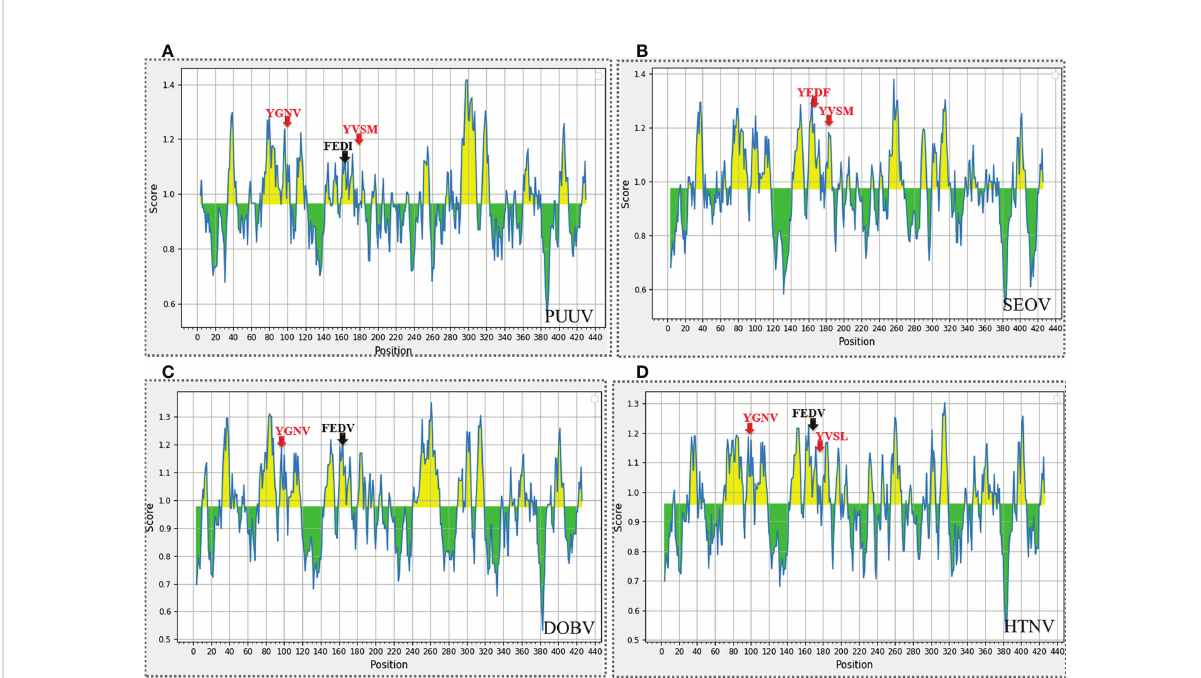
FIGURE 11 Immune epitope prediction of YXX F [I/L/M/F/V] motifs (in red color) and YXX F -like tetrapeptides (in black color) via Chou & Fasman method of b -turn prediction. (A) PUUV, (B) SEOV, (C) DOBV, and (D) HTNV. Those amino acids having scores >0.95 are highlighted with yellow while other amino acids were represented with